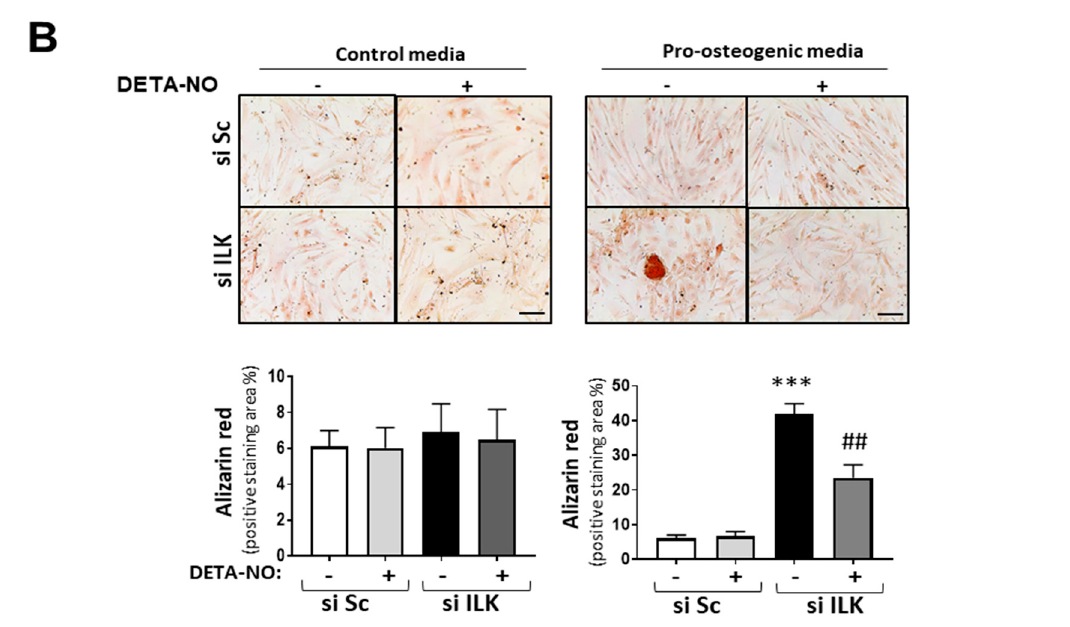
Figure 4. NO reverses the osteogenic phenotype induced by ILK silencing in hVECs. ( A ) Top: Scheme of the experimental design. Below: Western blot analysis (left) and quantification (right) of RUNX2 and BMP2. n = 8. * p < 0.05; *** p < 0.0001. ( B ) Alizarin Red staining. hVECs cultured with control medium or pro-osteogenic medium for 15 days were transfected with siSc or siILK for the last 7 days and treated with DETA-NO for 7 days. DETA-NO treatment was replenished every other day. Scale bar = 100 µ m. Below: Quantification of alizarin red positive area. n = 6. Pro-calcific medium: *** p < 0.0001 vs. Si Sc; ## p < 0.001 vs. Si ILK.